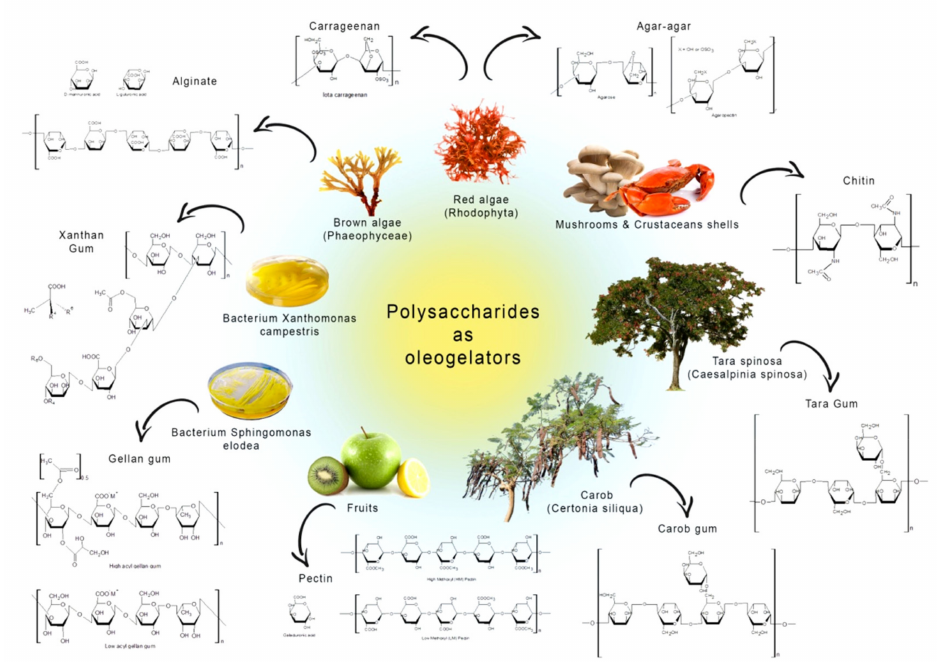
Figure 3. Natural gums structural conformation and